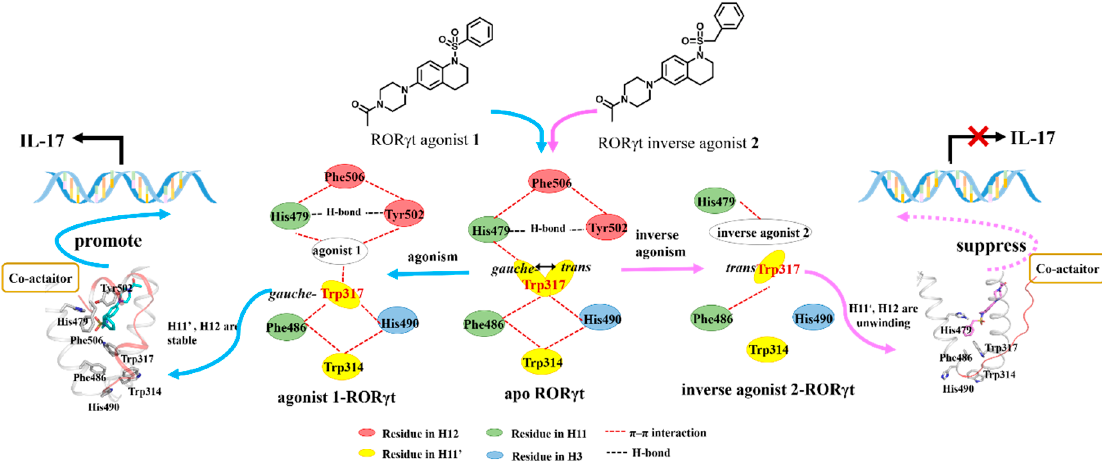
Figure 7. Representative description for the molecular mechanism of action (MOA) of the ROR γ t agonism and inverse agonism.